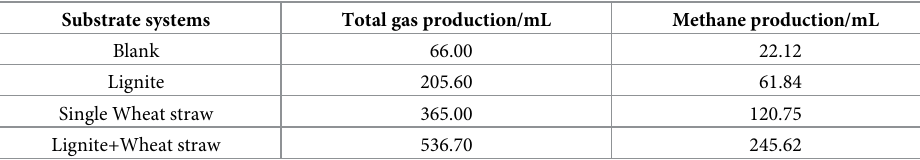
Table 3. Comparison of gas production of different substrate